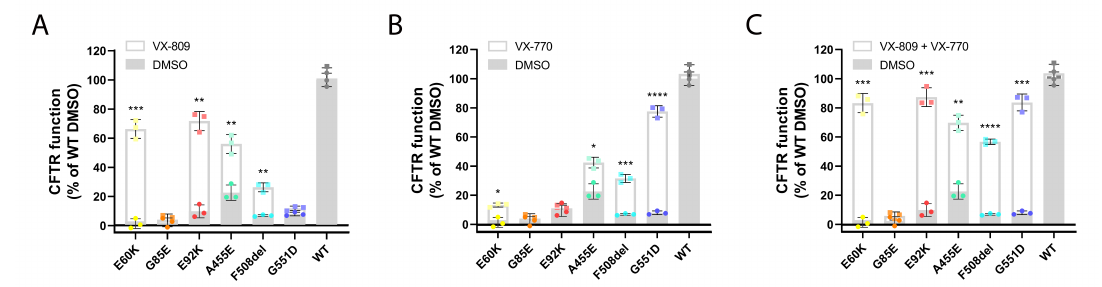
Figure 3. Rescue in CFTR function of rare CFTR mutants by VX-809 and / or VX-770. ( A – C ) HEK293T cells stably overexpressing untagged CFTR variants were treated with 2.5 µ M VX-809 for 24 h ( A ), 3 µ M VX-770 for 20 min ( B ) or a combination of both ( C ) prior to determining CFTR function by HS-YFP quenching after stimulation with 10 µ M forskolin (Fsk). Graphs depict the mean ± S.D. of three independent experiments represented as dots (DMSO) or squares (compounds). Response to treatment over DMSO was compared for each mutant by multiple t-testing. * P < 0.05, ** P < 0.01, *** P < 0.001, **** P <